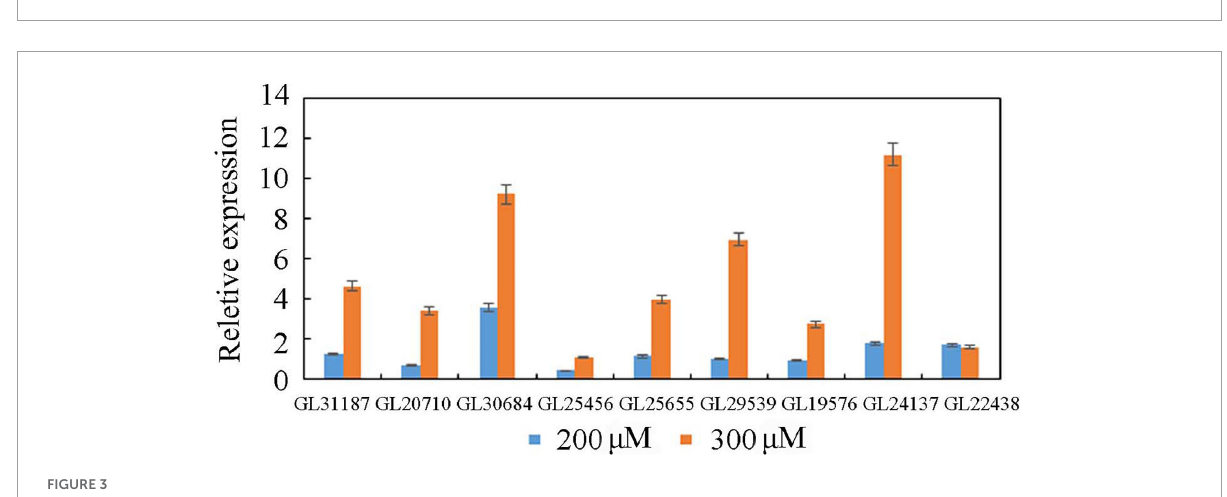
FIGURE3 Quantitative real-time PCR analysis of